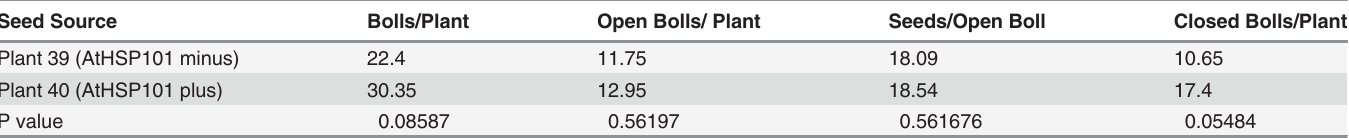
Table 3. Field performance of AtHSP101 minus (seed from plant #39) and AtHSP101 plus (seed from plant #40) cotton in Maricopa, Arizona during the 2007 growing season. Seed Source Bolls/Plant Open Bolls/ Plant Seeds/Open Boll Closed Bolls/Plant Plant 39 (AtHSP101 minus) 22.4 11.75 18.09 10.65 Plant 40 (AtHSP101 plus) 30.35 12.95 18.54 17.4 P value 0.08587 0.56197 0.561676 0.05484 Twenty plants per line were analyzed for total number of bolls per plant, open bolls per plant, seeds per open boll, and closed bolls per plant. Statistical analyses used an Unpaired Student's t test and the sample size was n =